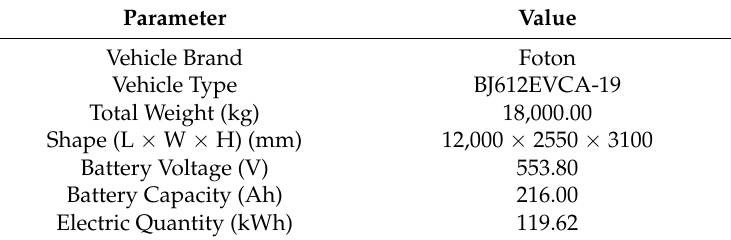
Table 1. Pure electric bus parameters.